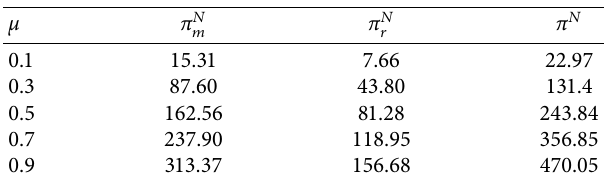
Table 3: The impact of organic food authenticity rate μ on supply chain